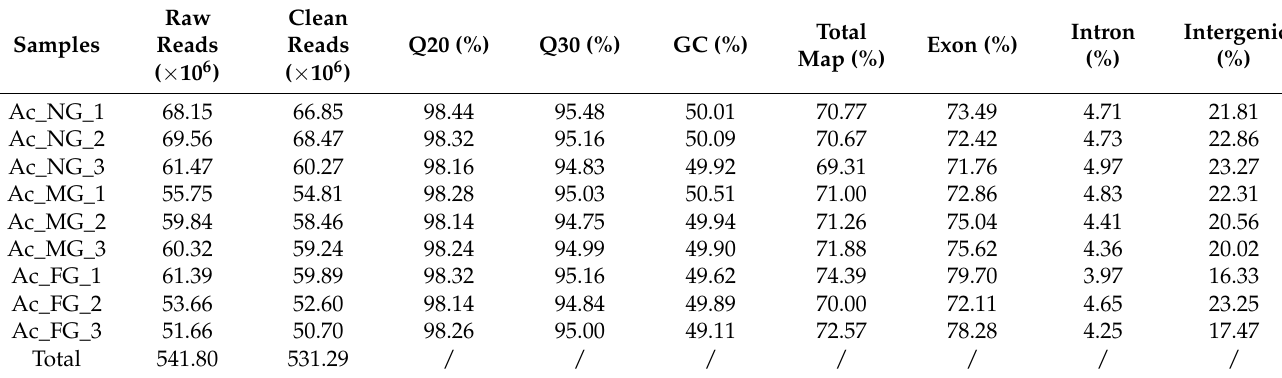
Table 1. Sequencing and assembly statistical for the gonadal transcriptomes of A. clarkii .